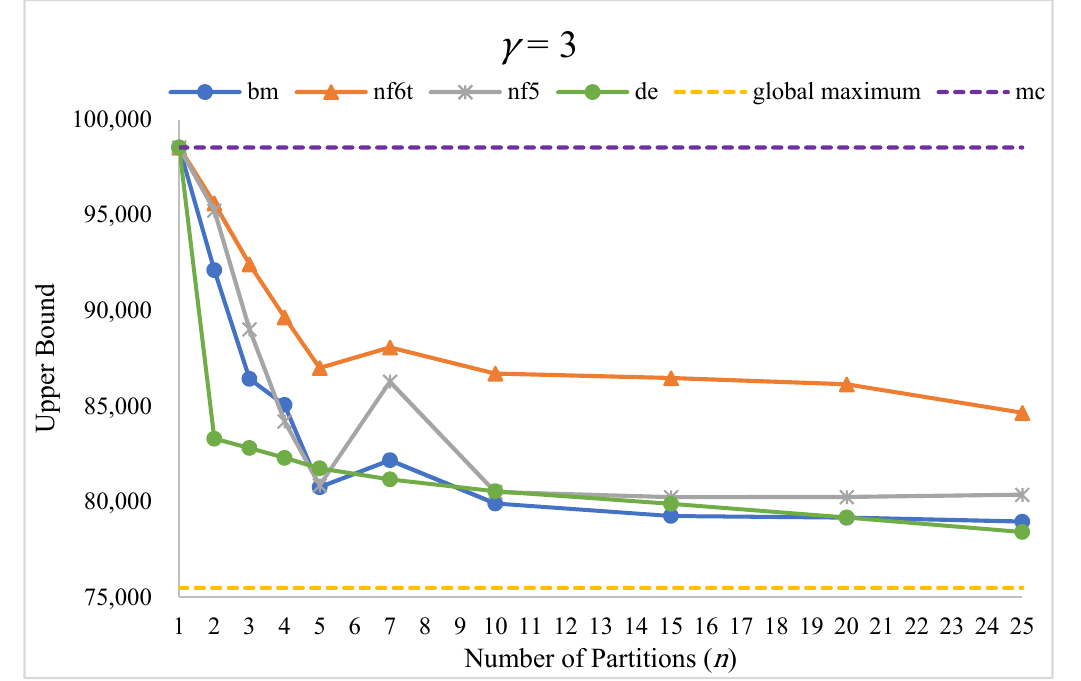
Figure 9. Convergence-indicating curves of the bm, de, nf5, and nf6t relaxation schemes for 𝛾 = 3.